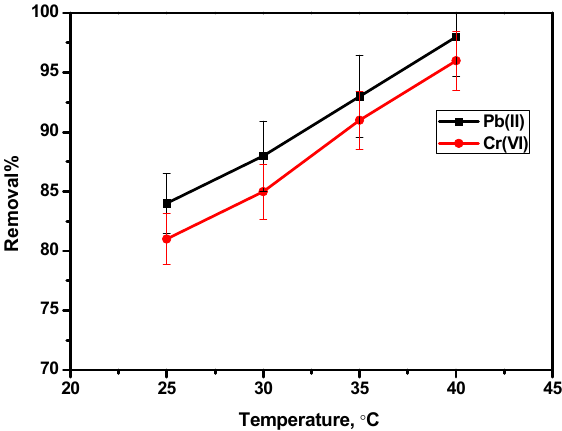
Figure 7. E ff ect of temperature on the adsorption e ffi ciency of Pb(II) and Cr(VI) on AAJPL. Figure 7. Effect of temperature on the adsorption efficiency of Pb(II) and Cr(VI) on AAJPL. Thermodynamic